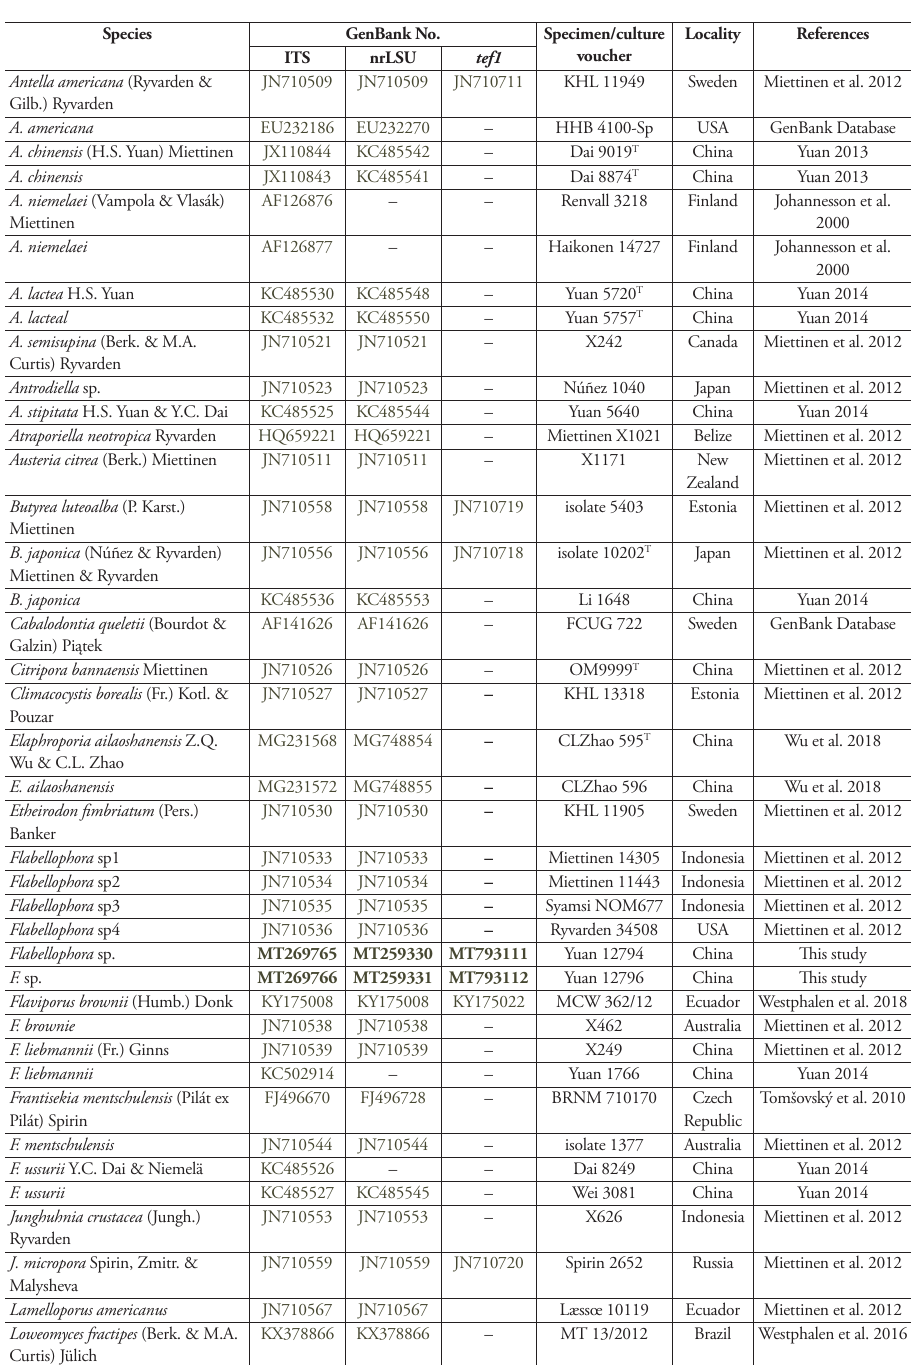
Table 1. Specimens and sequences used in this study. Type specimens are indicated as superscript T and the newly generated sequences in this study are in